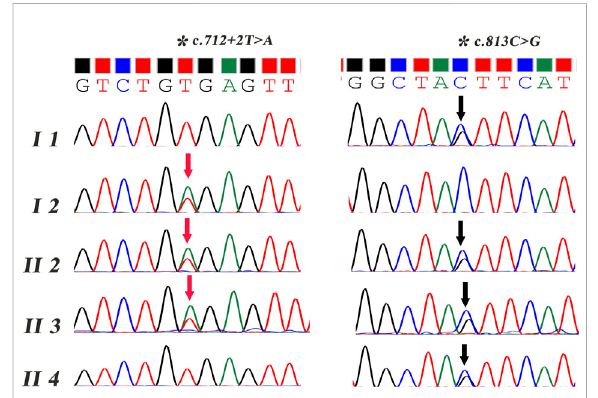
FIGURE 2 Sanger sequencing of the compound heterozygous variants in the JAM3 gene. The red arrow refers to the variant of c.712 + 2T > A. The black arrow refers to the variant of c.813C >